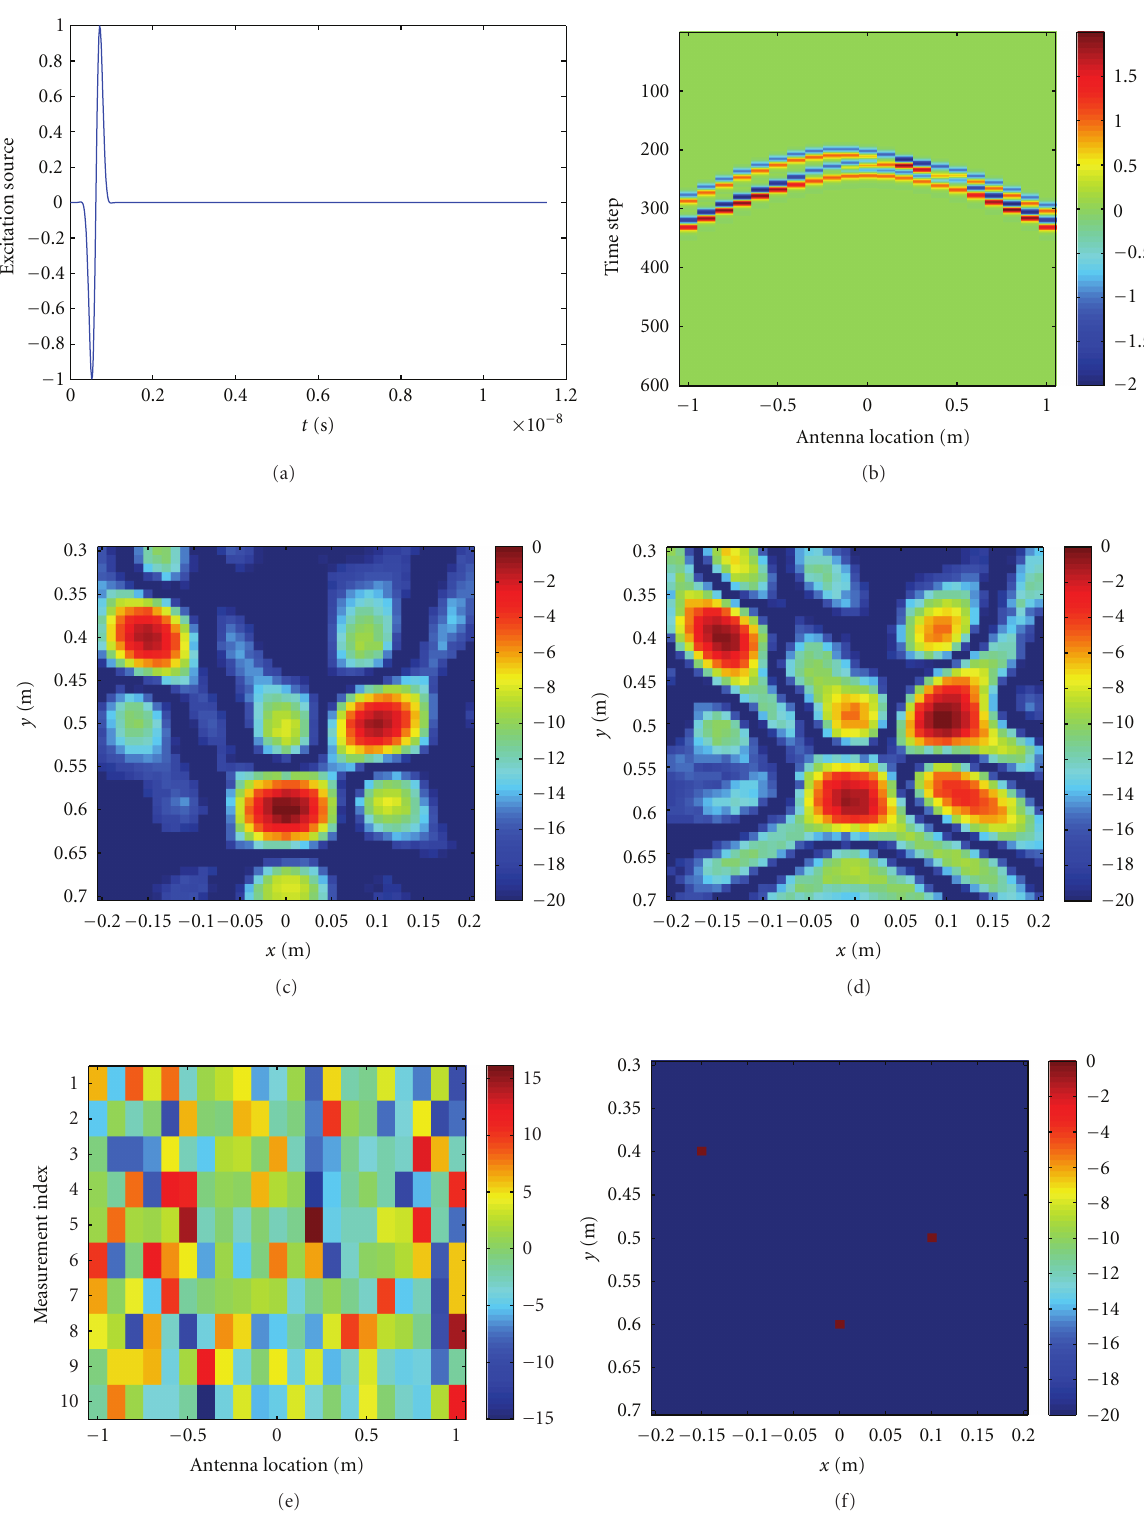
Figure 3: Imaging results of three point targets: (a) Excitation pulse, (b) Conventional radar measurement, (c) TDBP result with full data, (d) TDBP result with undersampled data, (e) CS measurement, and (f) CS